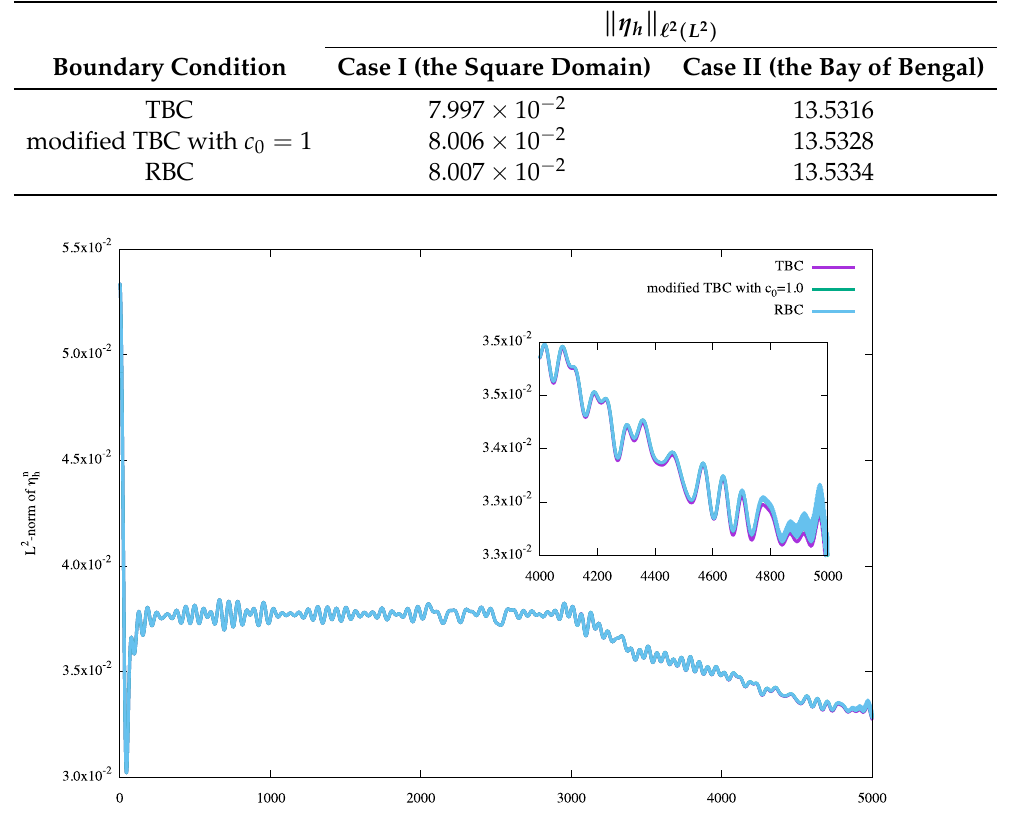
Table A2. Valuesof (cid:107) η h (cid:107) (cid:96) 2 ( L 2 ) for different boundary conditions for Case I and Case II.